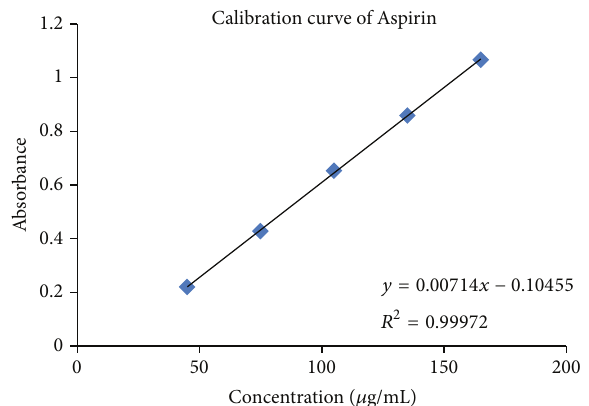
Figure12:CalibrationcurveofAspirin(45–165 𝜇 g/mL)byratiofirst order derivative